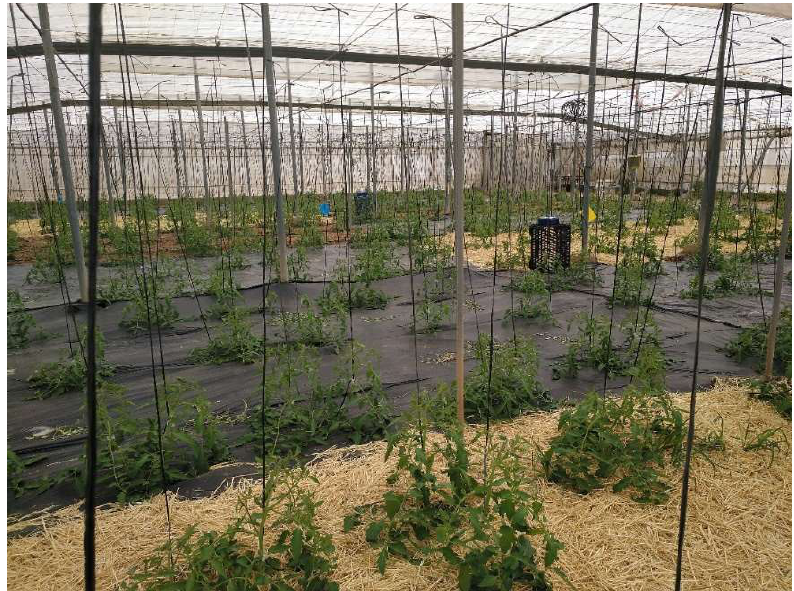
Figure 1. General view of the experiment at 30 days post planting (Year